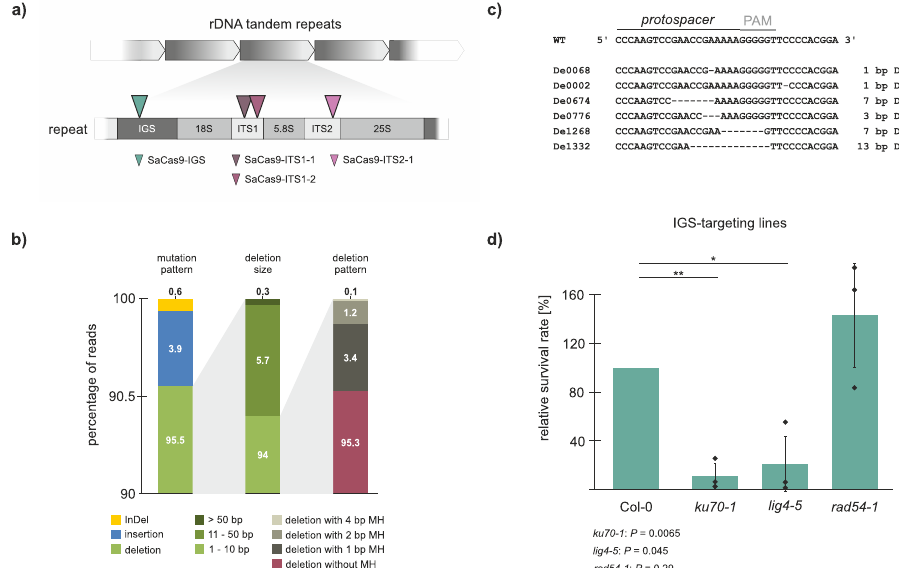
Fig. 1 Cleavage of the IGS region of the 45S rDNA repeats in Arabidopsis using SaCas9. a The 45S rDNA in Arabidopsis is arranged in up to 750 repeats, in a head-to-tail-fashion. Each repeat consists of a unit of three rRNA genes (18S, 5.8S, and 25S), separated by a variable intergenic spacer (IGS) region. The individual rRNA genes are separated by two highly conserved internal transcribed spacers (ITS). The triangles represent the cleavage sites for SaCas9 within the repeats. By targeting the variable IGS region (petrol), only a subset of repeats was cleaved. b The break site was analyzed by deep sequencing. Only a very small fraction of mutations was identi fi ed as InDels (yellow) or insertions (blue), whereas over 95% were deletions (green). Further analysis of the reads, including the deletions, showed that 94% of these were small deletions with a size of 10 bp or smaller. The deletion pattern of these small deletions revealed that no microhomologies were used for the repair (red). c Detailed illustration of exemplary junctions with deletions in Col-0 plants on the sequence level. d Cleavage of the IGS region in DNA repair mutants revealed that only the cNHEJ mutants, ku70-1 and lig4-5 , but not the HR mutant, rad54-1 , responded highly sensitive, resulting in a drastically reduced survival rate ( n = 3 biologically independent experiments). Data are presented as normalized mean values ± SD. Statistical differences were calculated using the two-tailed t -test with unequal variances: * P < 0.05, ** P < 0.01, *** P < 0.001, **** P < 0.0001. Source data are provided as a Source data fi